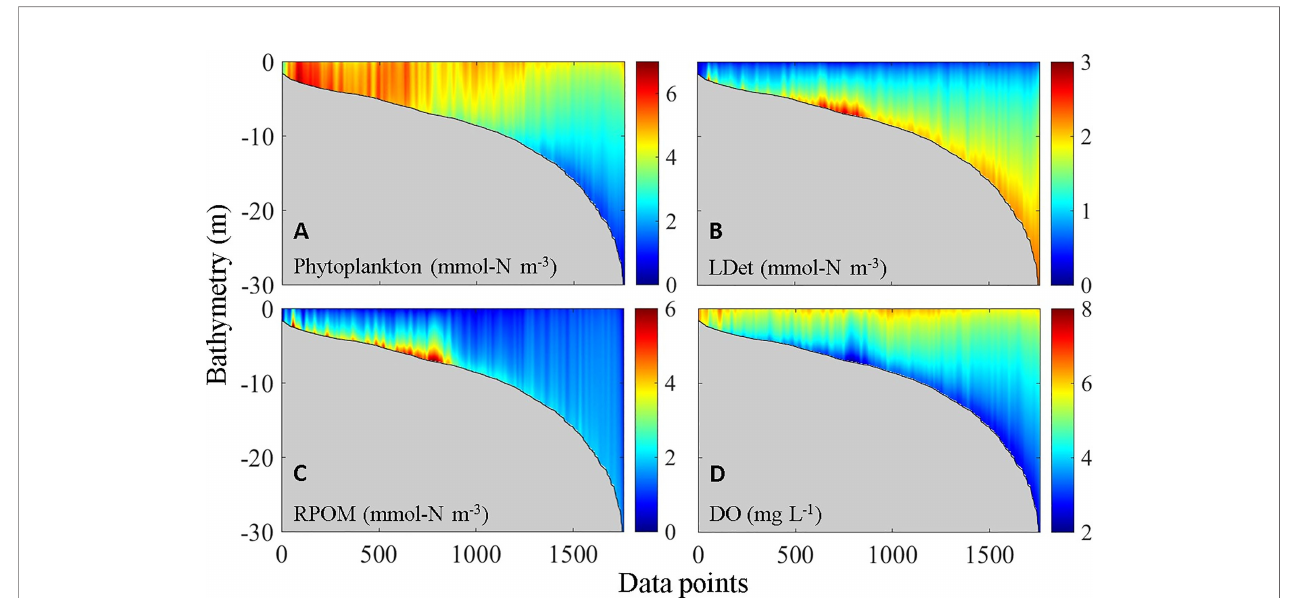
FIGURE 5 | Vertical distribution of (A) phytoplankton, (B) LDet, (C) RPOM, and (D)